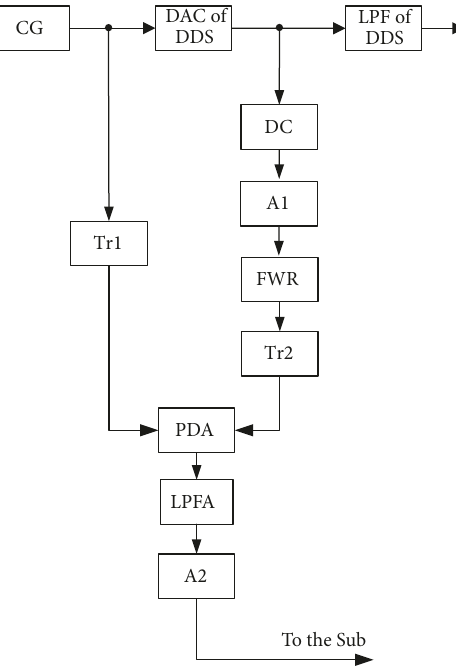
Figure 6: Block diagram of the control signal formation channel of the ACPD of the